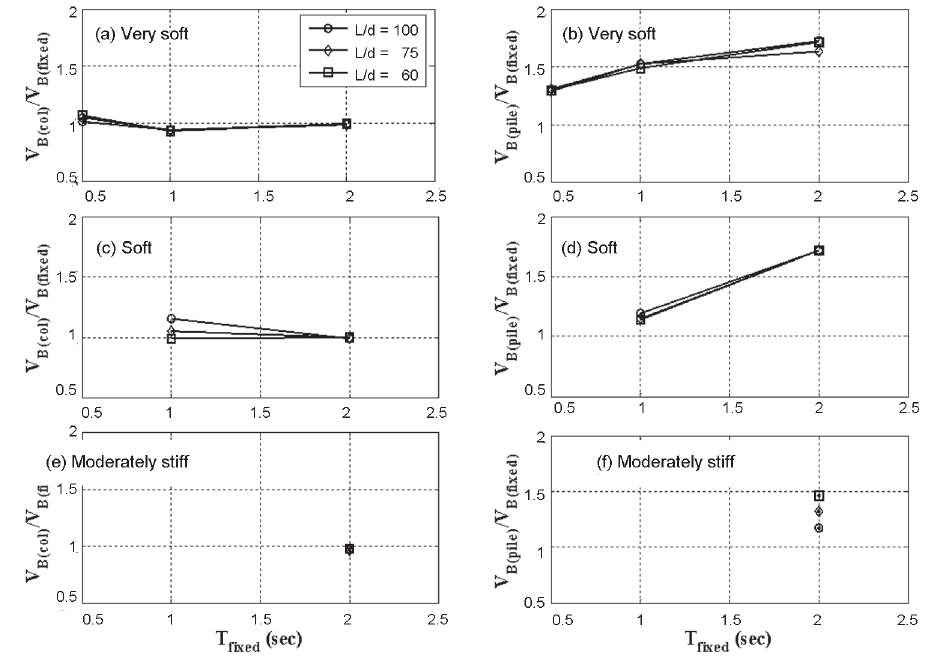
Fig. 9. Variations of normalised base shear for parabolic variation of soil modulus for different L/d ratios: a) V B(col) / V B(fixed) versus T fixed for very soft soil; b) V B(pile) / V B(fixed) versus T fixed for very soft soil; c) V B(col) / V B(fixed) versus T fixed for soft soil; d) V B(pile) / V B(fixed) versus T fixed for soft soil; e) V B(col) / V B(fixed) versus T fixed for moderately stiff soil; f) V B(pile) / V B(fixed) versus T fixed for moderately stiff